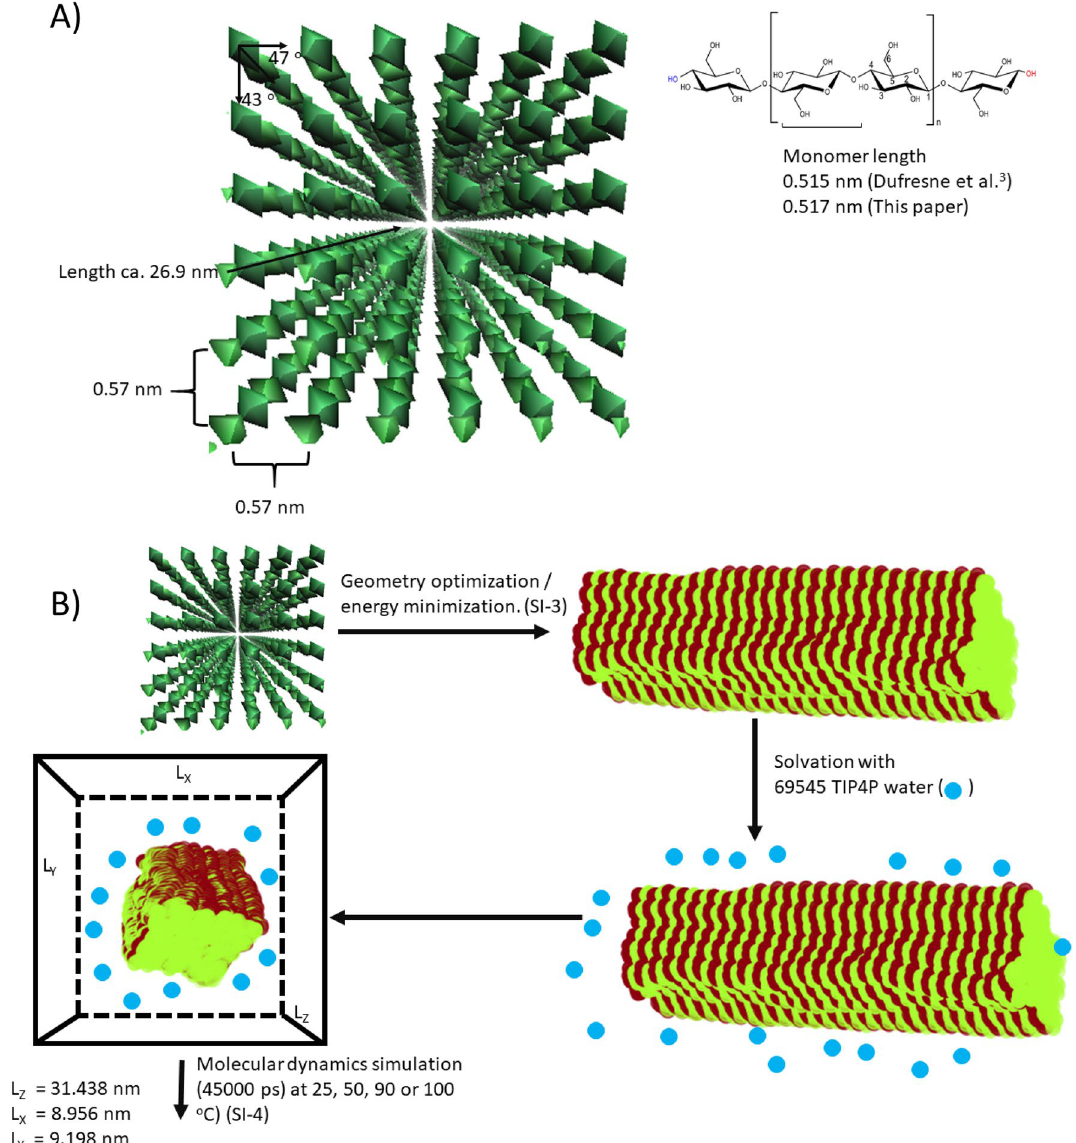
Figure 2. Overview of the initial cellulose bundle/nanofibril and modeling in this paper. ( A ) The fibril structure and ( B ) the performed